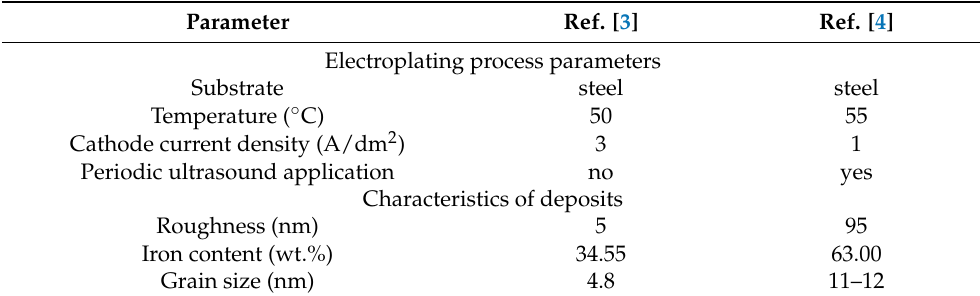
Table 1. Electroplating process parameters and some characteristics of